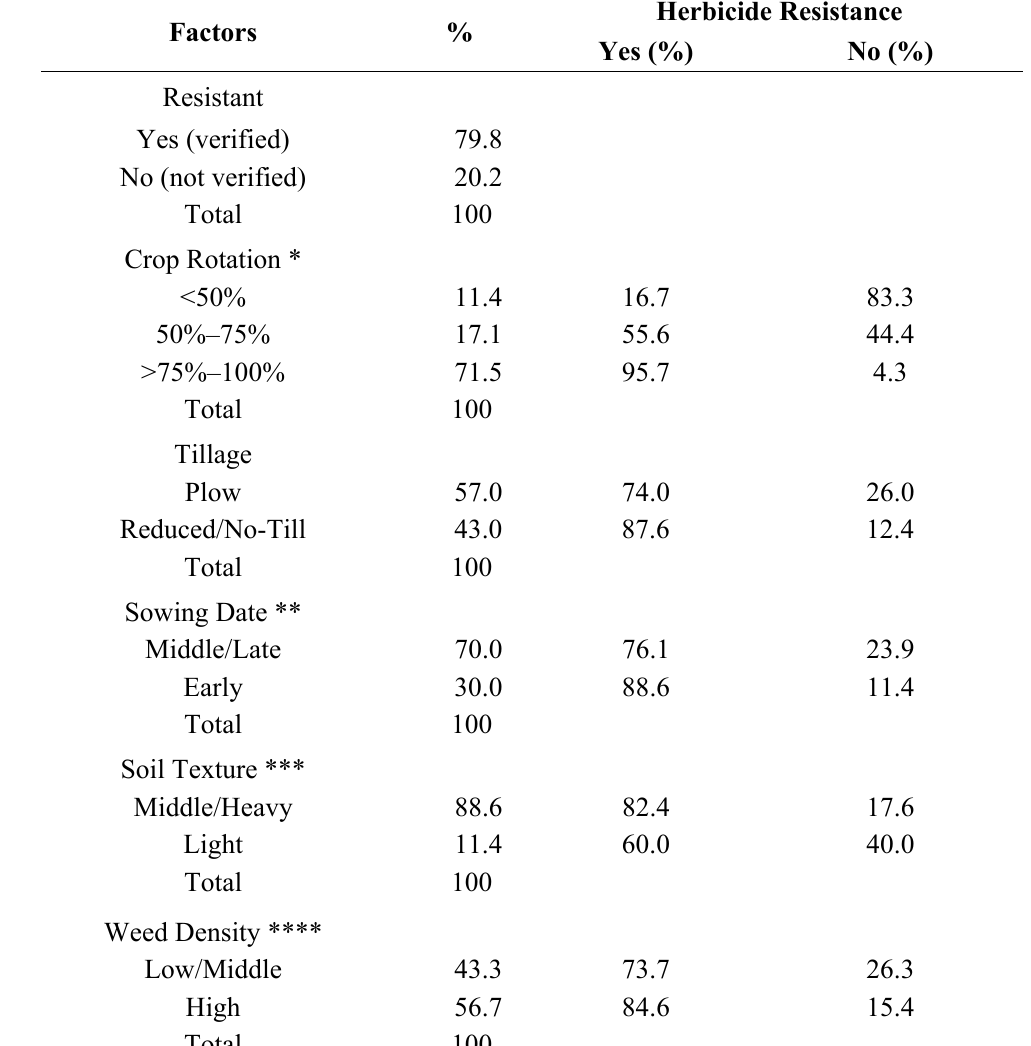
Table 1. Frequency distribution of cases (in %) within each category of analyzed factors (resistance, crop rotation, soil tillage, sowing date, soil texture and weed density). Frequency distribution of herbicide resistance is shown in each factor